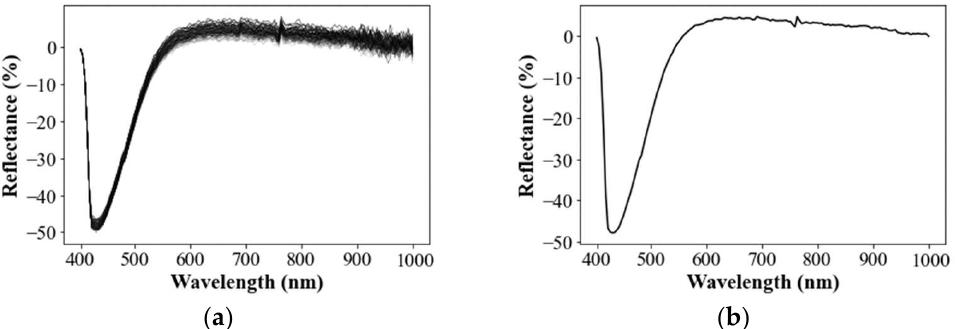
Figure 6. Derivation of a mean and filtered spectral signature for a hazardous chemical (bromine) using the super smoother. ( a ) A bundle of residual reflectance for bromine; ( b ) a derived spectral signature after applying filter and the super smoother.